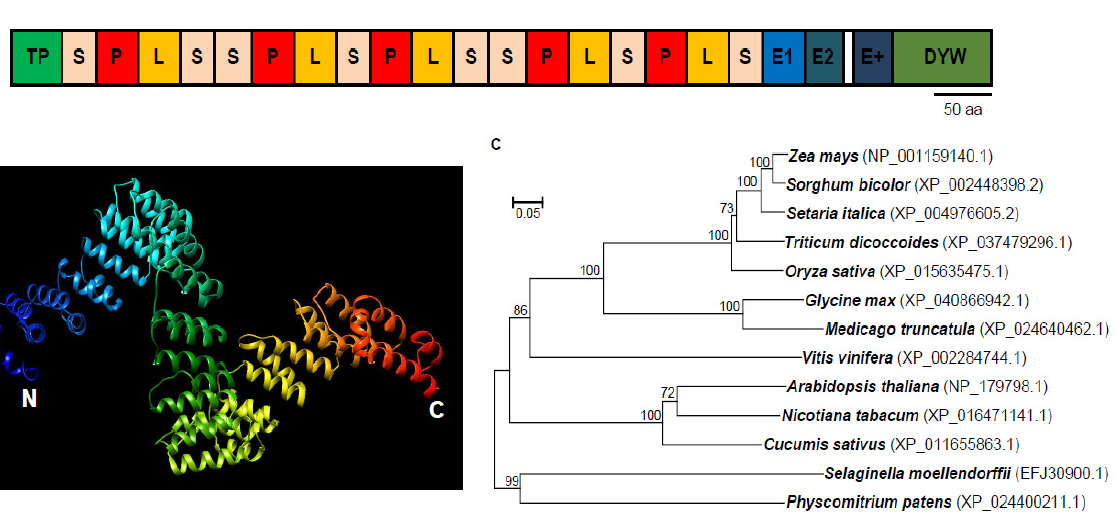
Figure 1. Dek48 encodes a canonical DYW-type PPR protein. ( A ) The predicted DEK48 contains 18 PPR motifs, an E1/E2, an E+ domain, and a DYW domain. TP; targeted peptide. aa; amino acid. ( B ) Predicted structure of DEK48 protein. Blue alpha helices indicate the N-terminus and red helices indicate the C-terminus of DEK48. ( C ) Phylogenic analysis of DEK48 proteins in representative spe- cies.